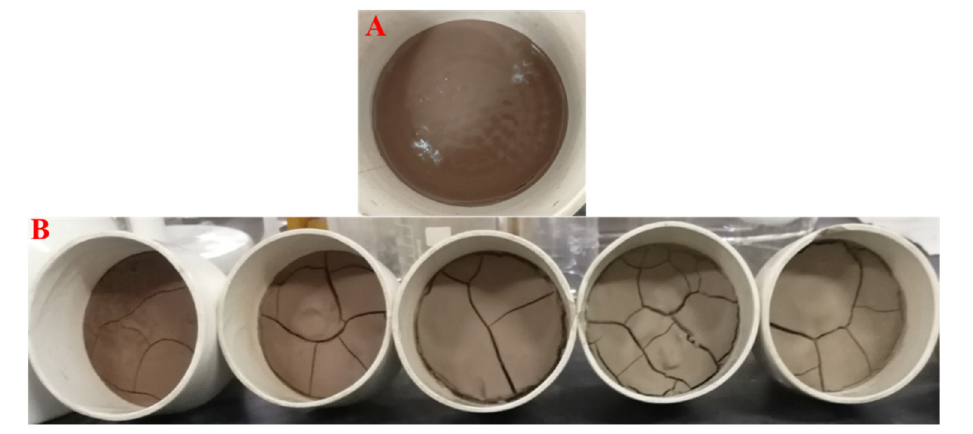
Figure 15. Effect of CaO addition on the filtration performance of red mud. ( A ) without adding calcium oxide, ( B ) with adding calcium oxide.